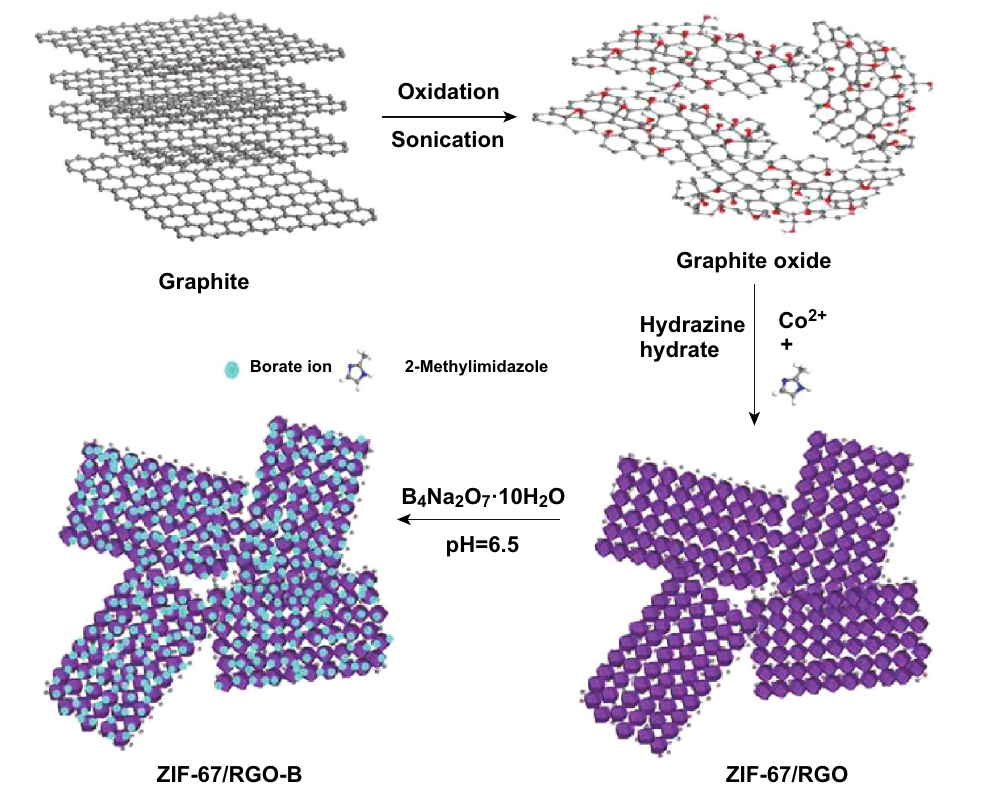
Fig. 13 Scheme for preparing the borate ion modification of ZIF‑67/RGO. Reproduced from Ref. [62] with permission from